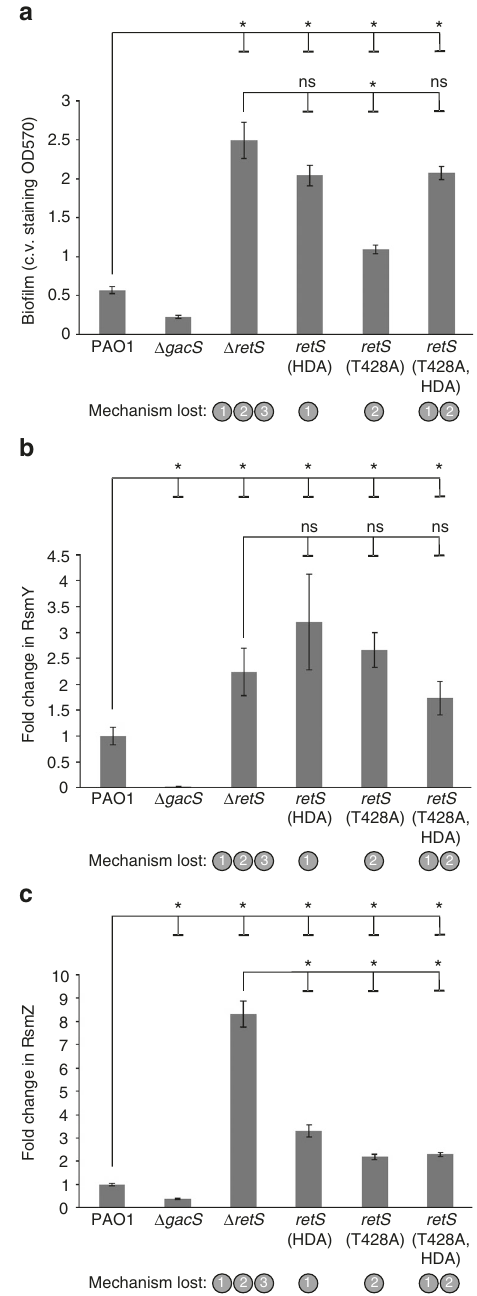
Fig. 2 Mechanisms 1 and 2 control bio fi lm formation and the expression levels of RsmY, while all three mechanisms contribute to controlling RsmZ levels. a Quanti fi cation of bio fi lm formation on peg-lidded 96-well plate by crystal violet staining. Plates inoculated with the mutant strains were incubated for 10h with shaking at 37°C. Error bars show SEM (three biological repeats each containing fi ve technical repeats). *Indicates signi fi cantly different comparisons ( P< 0.05, one-way ANOVA). See also Supplementary Fig. 4 for these mutations in a Δ gacS background. b , c Relative expression level of RsmY ( b ) and RsmZ ( c ) in the mutant strains relative to the wild-type PAO1 strain. RNA levels were measured using qRT-PCR. Error bars show SEM (three biological repeats, with three technical repeats per biological repeat). *Indicates signi fi cantly different comparisons ( P< 0.05, one-way ANOVA). The mechanisms disabled in each mutant strain are